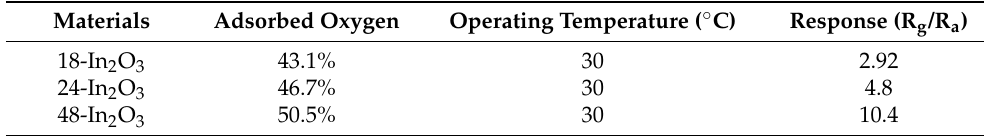
Table 4. Comparison of adsorption and activation abilities of methane molecules on the In 2 O 3 (110) surface (with oxygen vacancies) in the presence or absence of adsorbed oxygen.